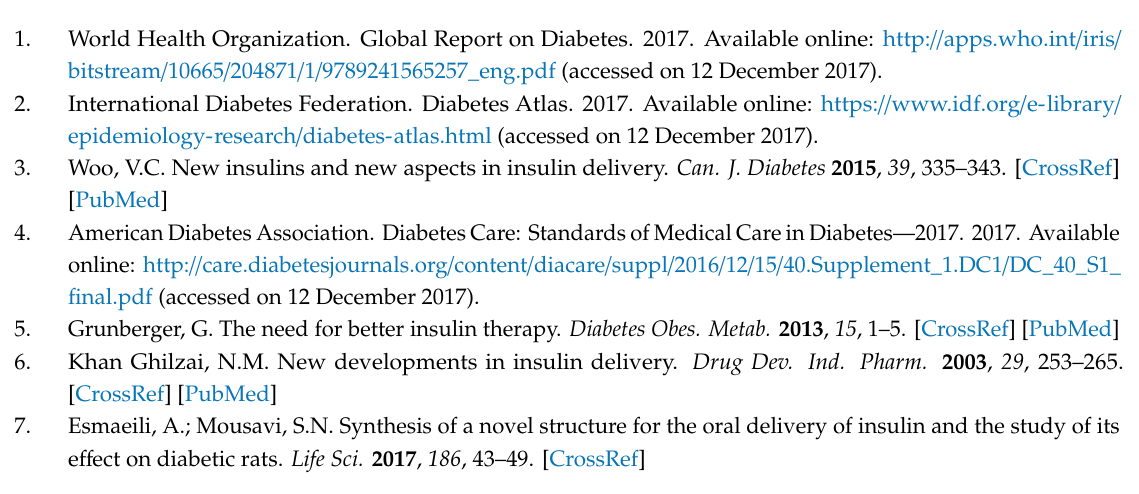
Table S1: Information on 55 experimental articles from 1998 to 2018 which deal with the development of chitosan / insulin delivery